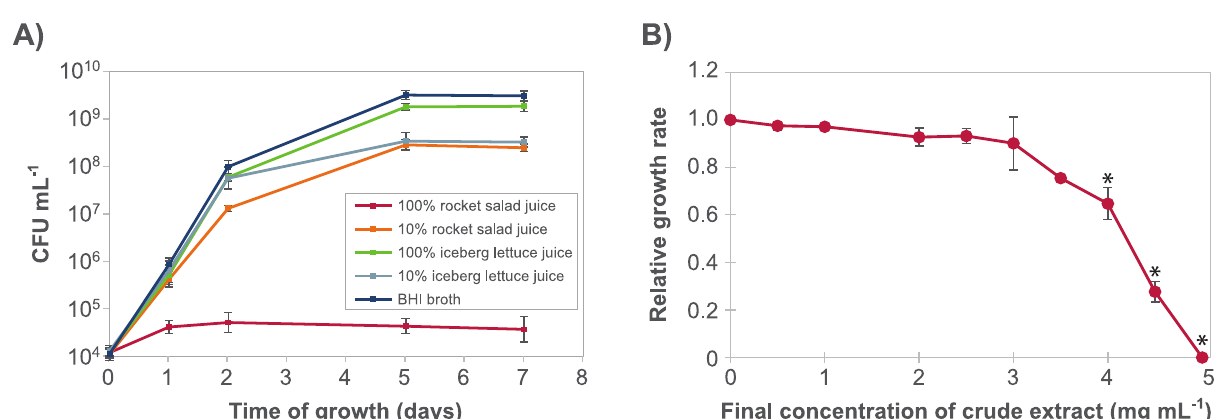
Fig 2. The anti-listerial activity was present in rocket salad juice and retained after extraction. A) Growth curves for L . monocytogenes MF1509 at 12˚C in BHI and in undiluted and 10% juice prepared separately from rocket salad and iceberg lettuce. The experiment was performed three times. All three individual replicates are shown in S3 Fig. B) Dose-response curve showing the inhibition of growth of L . monocytogenes (measured as relative growth rates obtained using the Bioscreen growth assay) as a response to increasing concentrations of crude extract from rocket salad juice. Each point in the graph is an average of three (0, 2.5, 5.0 mg mL -1 ) or two (all other concentrations) independent data points. A, B) Error bars show the standard error of the mean.